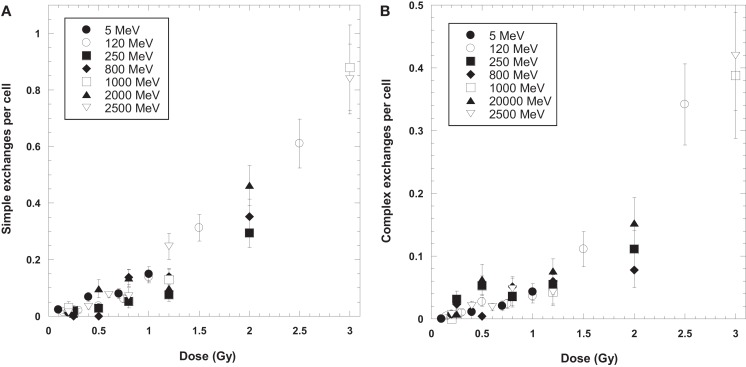
Dose response curves for simple (A) and complex (B) chromosome exchanges induced by each ion. Error bars indicate SEMs and background values have been subtracted for all data.